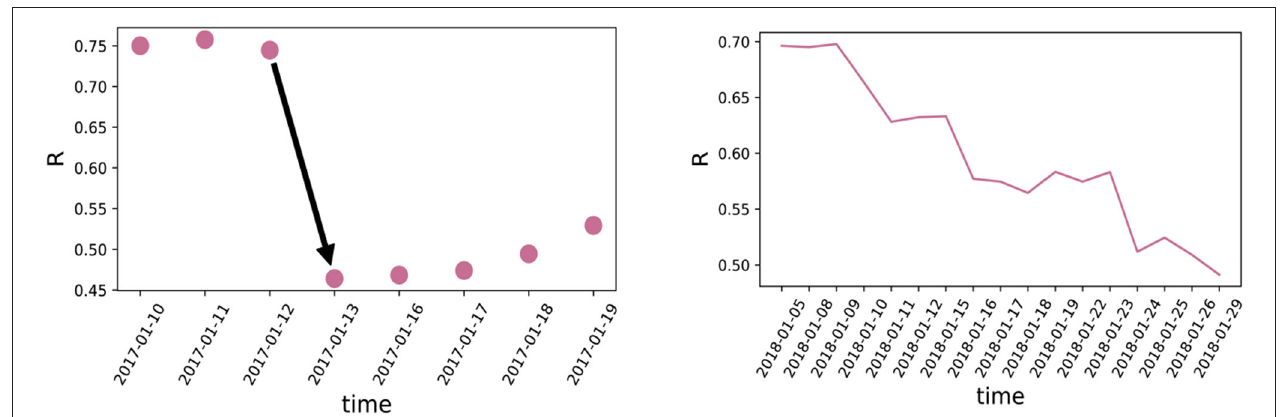
FIGURE 10 | Impacts of